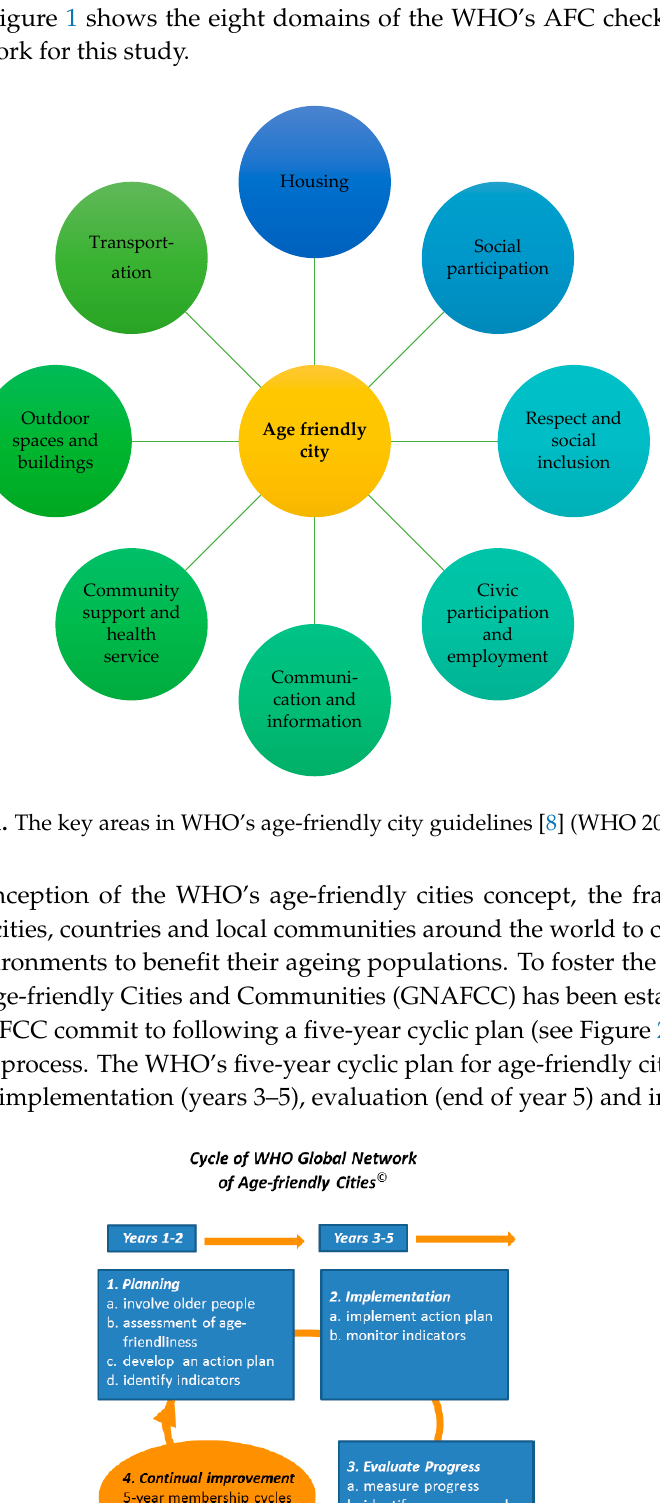
Figure 2. WHO Global Network of Age-friendly Cities planning framework [8].